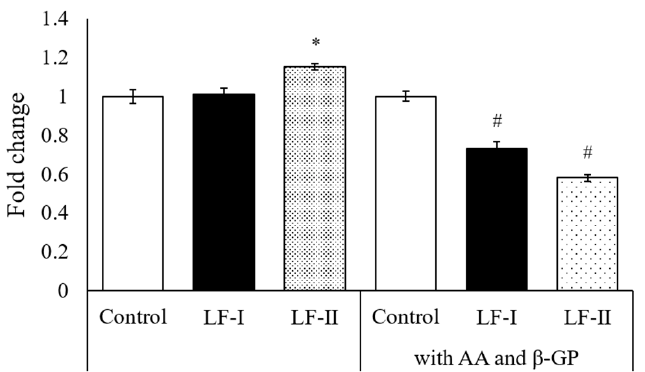
Figure 2. Results of both LFs treatment on MC3T3-E1 cells viability measured by MTT assay. The effects of LF were examined under two experimental set-ups: 1) without ascorbic acid (AA) and β -GP, 2) with AA (50 µ g/mL) and β -GP (10 mM). Data are means of change ratios ± SD. * p < 0.05, compared with the control for set-up 1 (without AA/ β -GP). # p < 0.05, compared with the control for set-up 2 (+AA/ β -GP). LF, lactoferrin; AA, ascorbic acid; β -GP, β